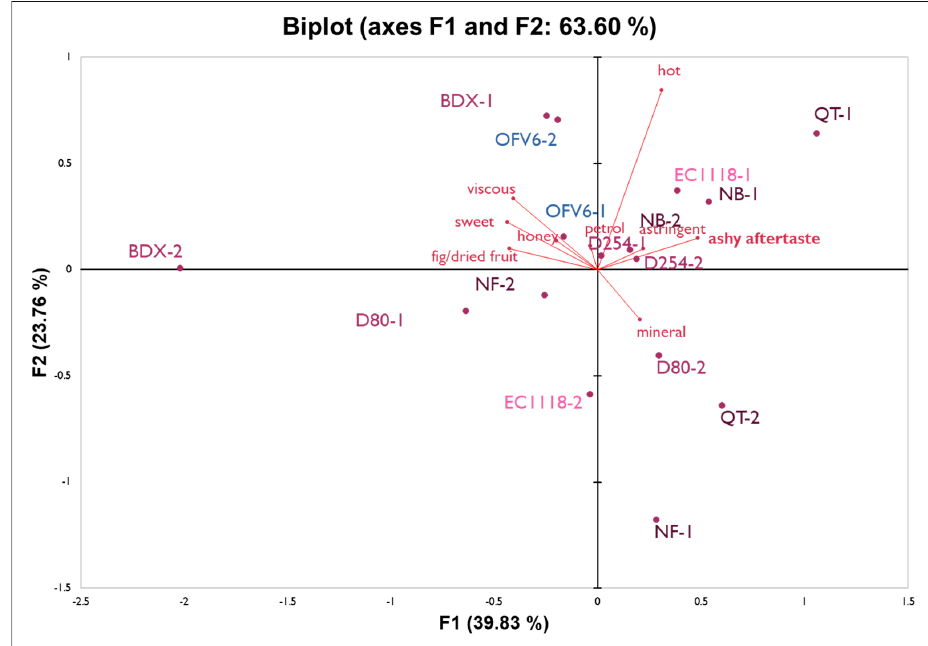
Figure 2. PCA biplot for yeast, oak, and tannin treatment in wines from Oakville, AVA.